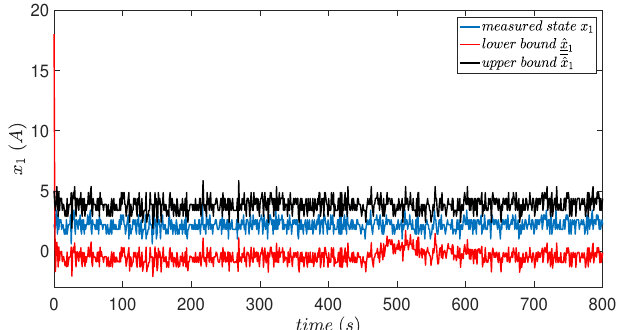
Figure 2. Measurement of armature current x 1 ( k ) and estimation of interval